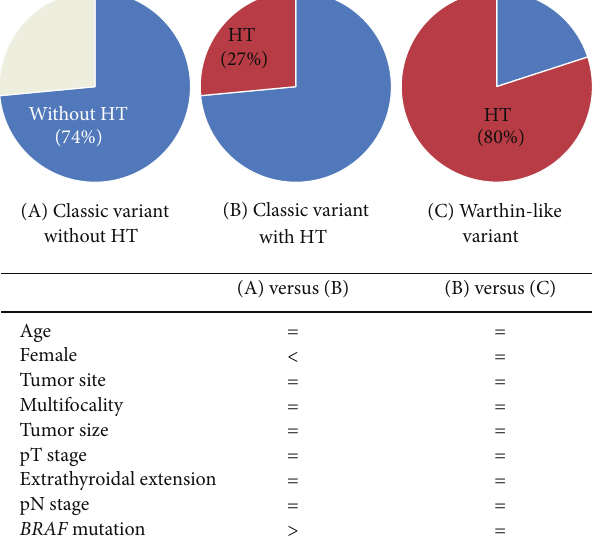
Figure 2: A schematic diagram summarizing the relationship between the Warthin-like variant of papillary carcinoma and classic papillary carcinomas with or without Hashimoto’s thyroiditis according to clinicopathologic